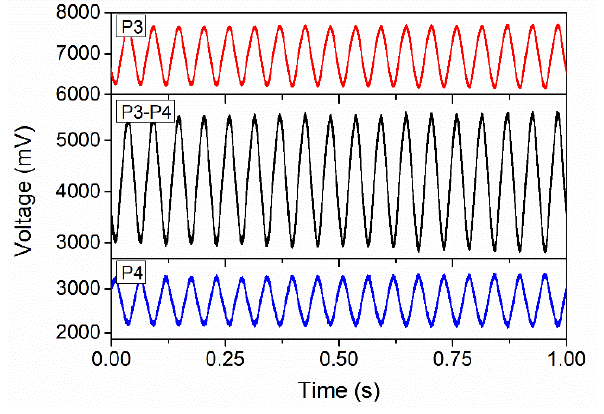
Figure 9. Measured signals from Ports 3 and 4 and the difference between Ports 3 and 4 under a 40 Hz acoustic wave.